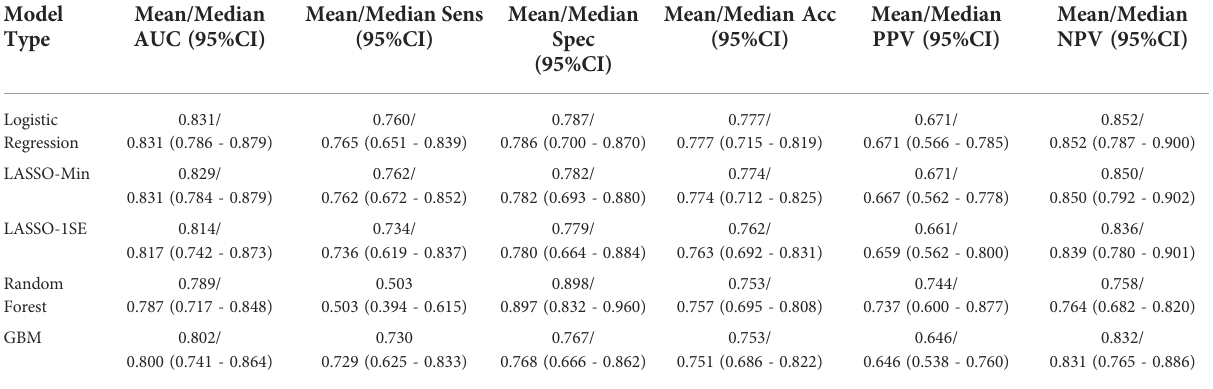
TABLE 4 Performance of fi ve different models during internal